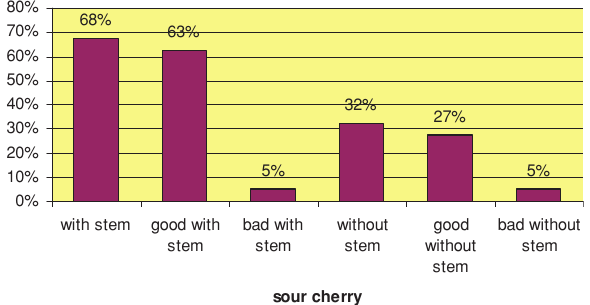
Figure 1. Distribution of the sour cherry offered with stem and without stem, of good and of bad quality in small shops